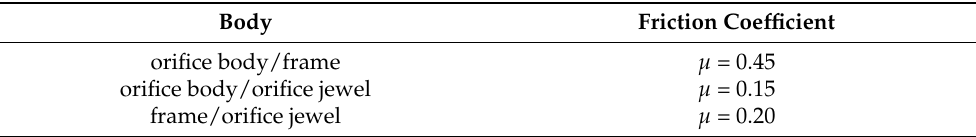
Table 3. Friction coefficients used in the numeric